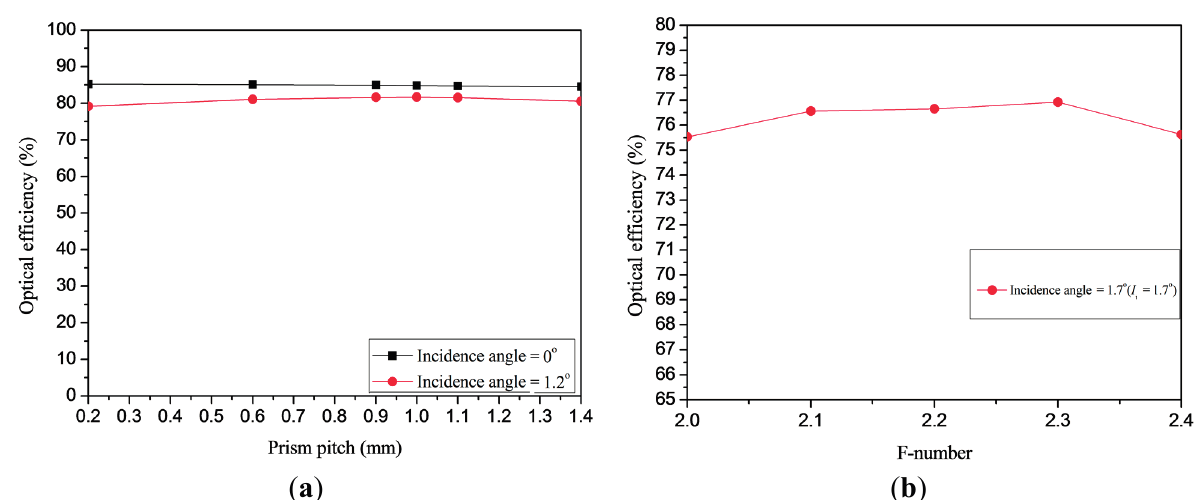
Figure 12. Optical efficiency ( a ) effect of prism pitch; ( b ) effect of F-number with a designed incidence angle I i of 1.7°.